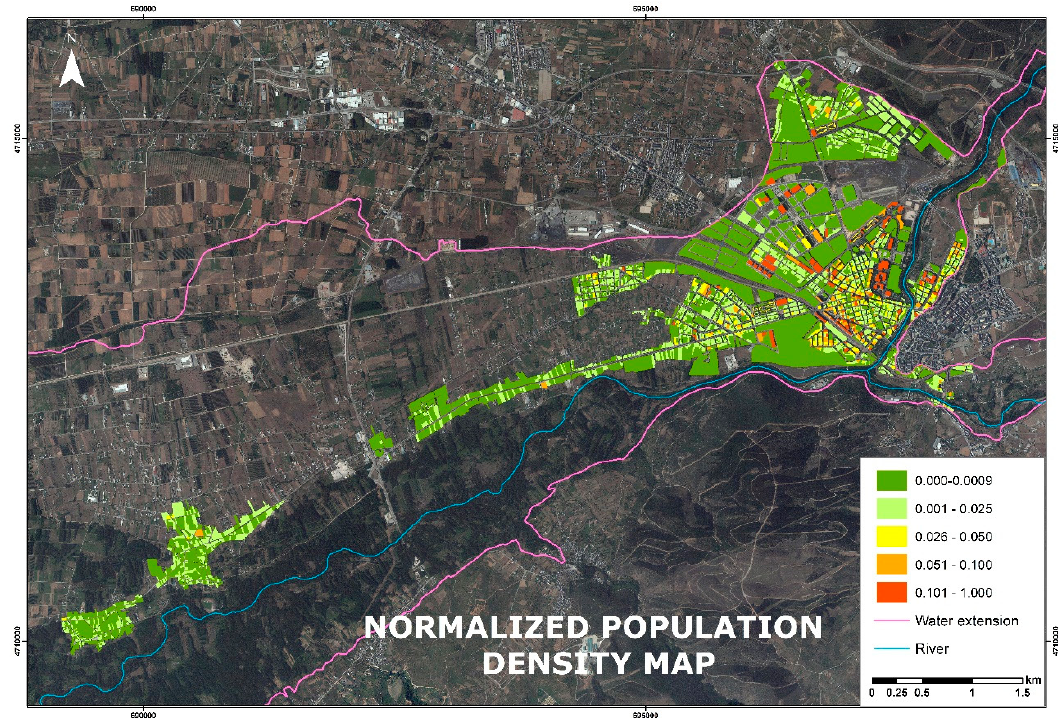
Figure 6. Normalized population density indicator in Ponferrada. Break values of the legend are adjusted to better visualize the spatial distribution of index values.